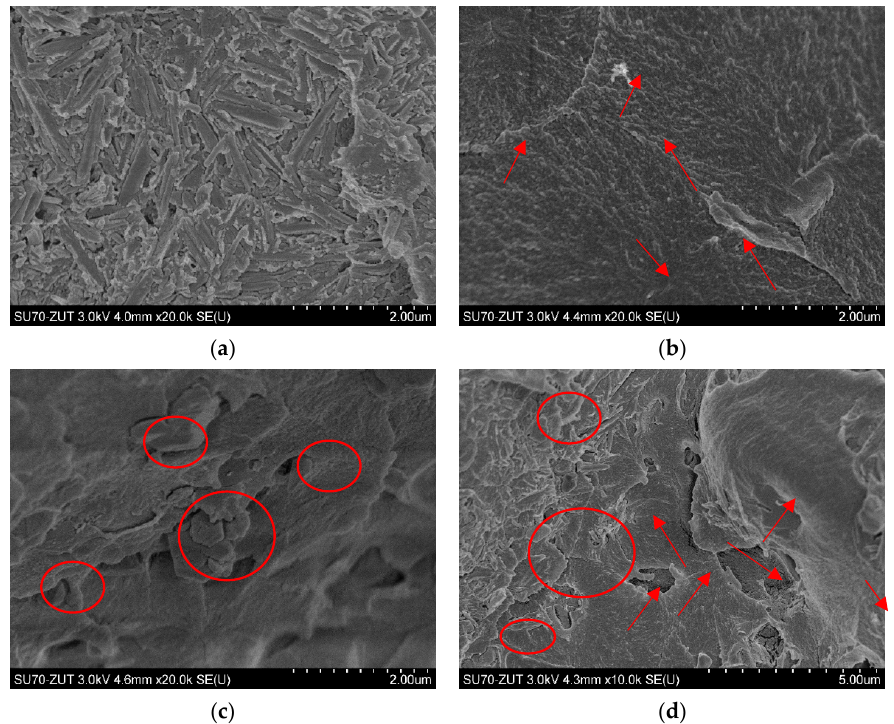
Figure 3. SEM micrographs of fracture surfaces of the composites containing: 5% HNT ( a ); 5% HNT-g ( b ); 5% ATH-sil ( c ), and 2.5% HNT-g + 2.5% ATH-sil ( d ).